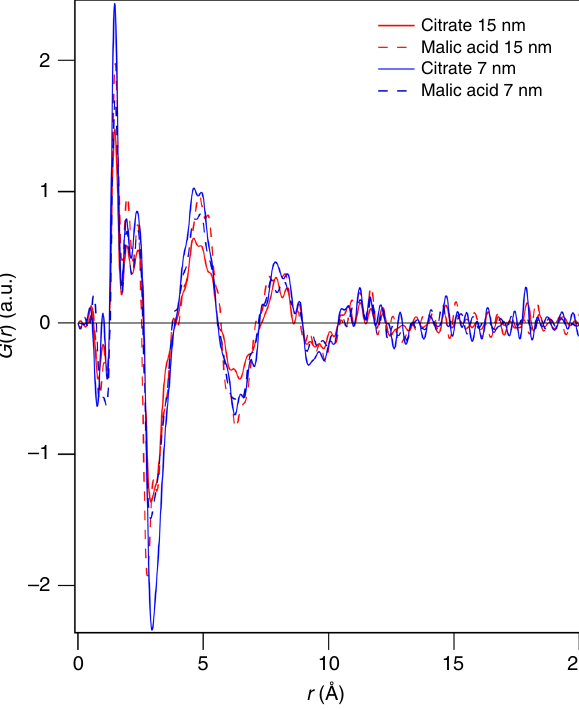
Fig. 4 Comparison of hydration shells for 7 and 15 nm iron oxide nanoparticles (IONPs). Double difference PDFs (dd-PDFs) of 7 (blue) and 15 nm (red) sized IONP with two different ligands; citrate (solid line) and malic acid (dashed line). The similarity of the dd-PDFs shows that the nanoparticle size does not in fl uence the structure of the hydration shell